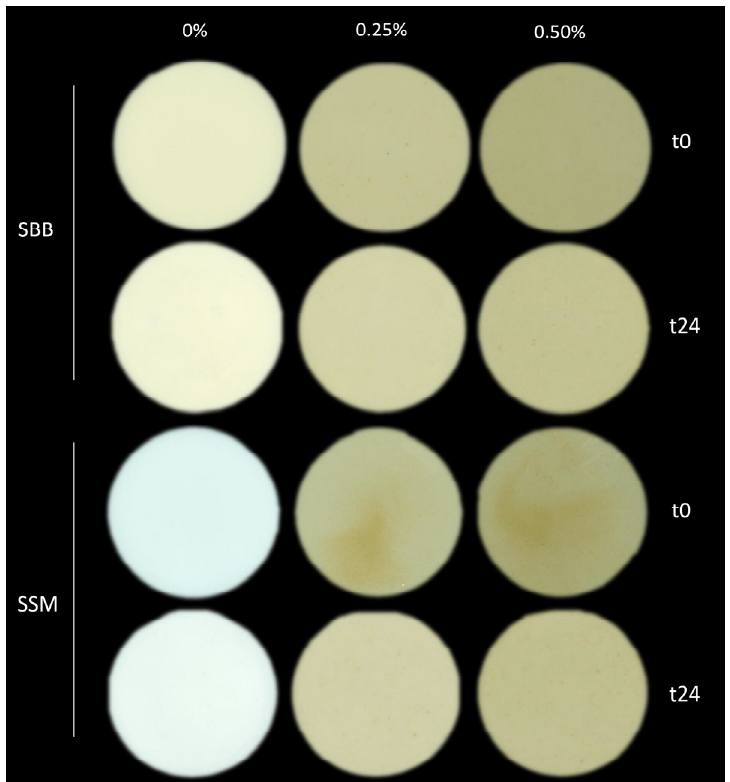
Figure 3. A representative picture of skimmed milk (SSM) and soy-based beverage (SBB) inoculated with commercial mix culture I, before (t0) and after 24 h (t24) of fermentation. Samples were fermented with the addition of 0, 0.25, and 0.5% ( v / v ) lysate of Arthrospira platensis .